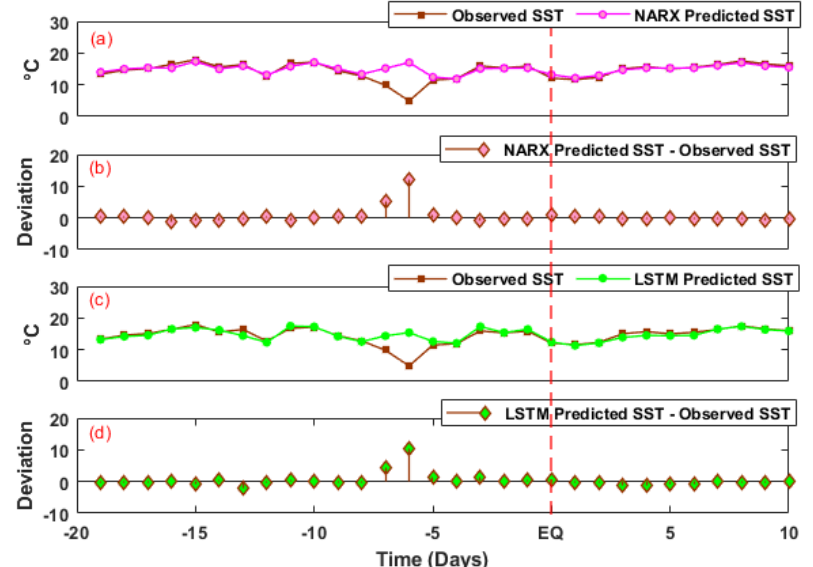
Figure 9. ( a ) Data variations between observed time series MODIS-SST and NARX-predicted SST values, ( b ) Deviation of NARX-predicted SST values from Observed SST values, ( c ) Variations between observed MODIS-SST values and LSTM train SST values, ( d ) Deviation of LSTM-predicted SST values from Observed SST data. The red dashed line shows earthquake day.